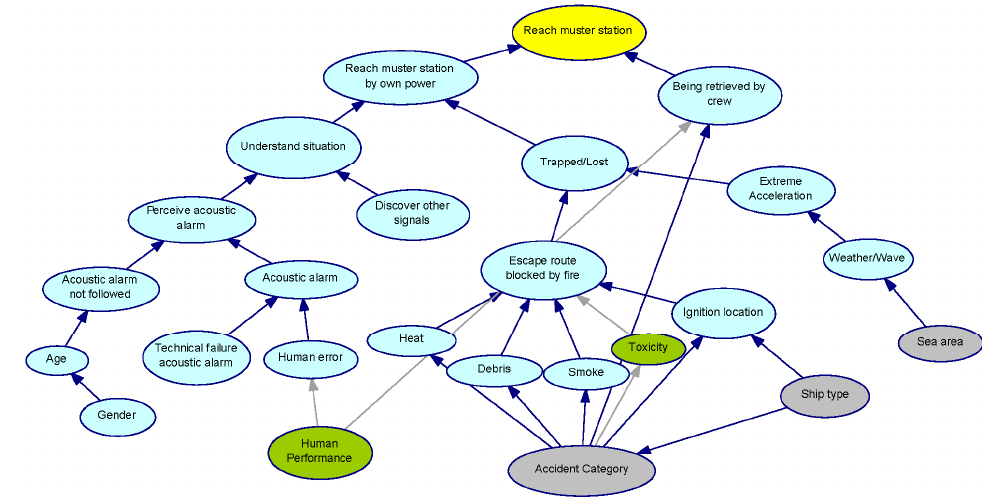
Figure 6. Bayesian network for the mustering process in fire/explosion accidents (02 FX ).